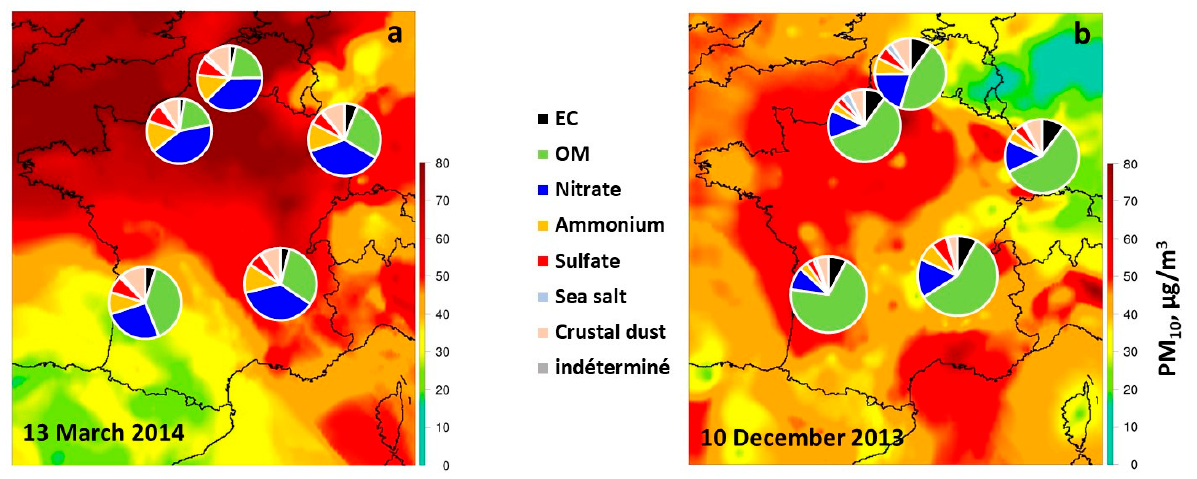
Figure 8. Examples of daily PM 10 chemical composition observed for five urban stations (Lens, Rouen, Strasbourg, Lyon, and Bordeaux) during two different types of pollution episodes, along with PM 10 concentration mapped using the Prev’Air modeling system (http://www2.prevair.org) analyzed with in situ PM 10 measurements. ( a ) 13 March 2014, ( b ) 10 December